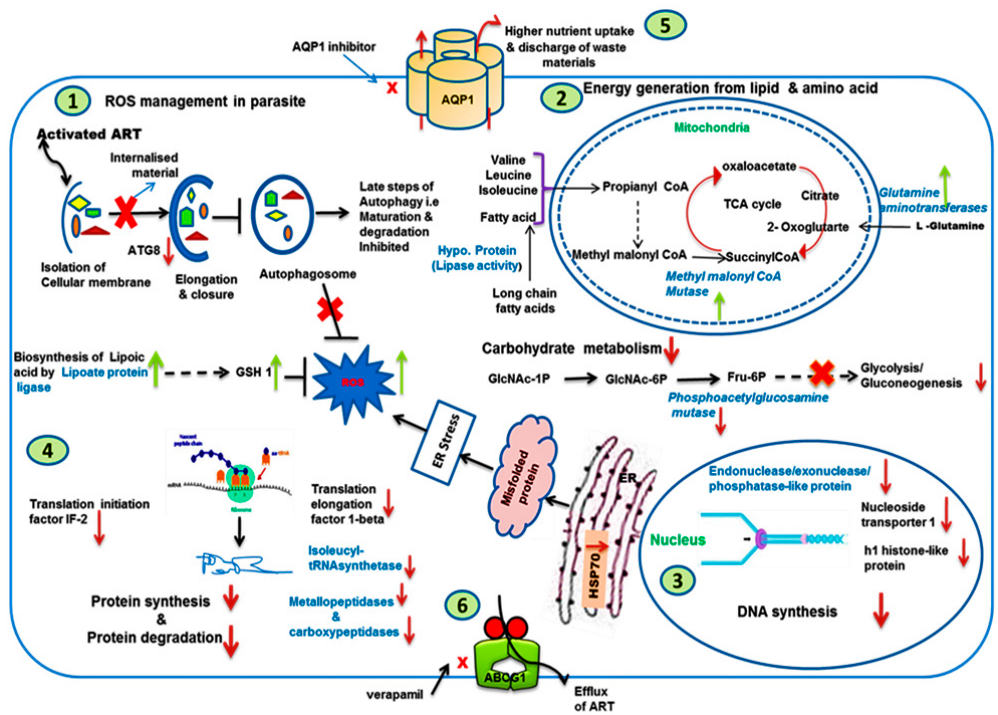
Figure 9. Transcriptome predicted adaptations contributing artesunate resistance in L. donovani : Genes altered in K133AS-R parasites are represented here. Genes marked with an up and down arrow represent, respectively, the upregulated genes and the downregulated genes in K133AS-R parasites. 1, 2, 3, 4, 5, and 6 are probable adaptations in K133AS-R parasites. (1.) Downregulation of Atg8 and HSP70 leads to increased ROS production, which was compensated by upregulation in the expression of GSH1, (2.) Upregulated expression of enzymes involved in amino acid and lipid metabolism and downregulated expression of the enzyme involved in carbohydrate metabolism, suggesting a dependency on these metabolites for energy generation, (3.) Reduced DNA synthesis that leads to the parasites in the quiescence state may be responsible for artesunate resistance in Leishmania , (4.) Reduced protein synthesis and reduced protein degradation, (5.) Upregulated expression of AQP1 leads to higher nutrient uptake and increased discharge of waste material and metabolic end product from the parasites and (6.) Upregulated expression of ABC transporter (ABCG1) and partial reversion or resistance in the presence of the ABC transporter modulator verapamil suggested probable involvement of the ABC transporter in the efflux of artesunate drug.